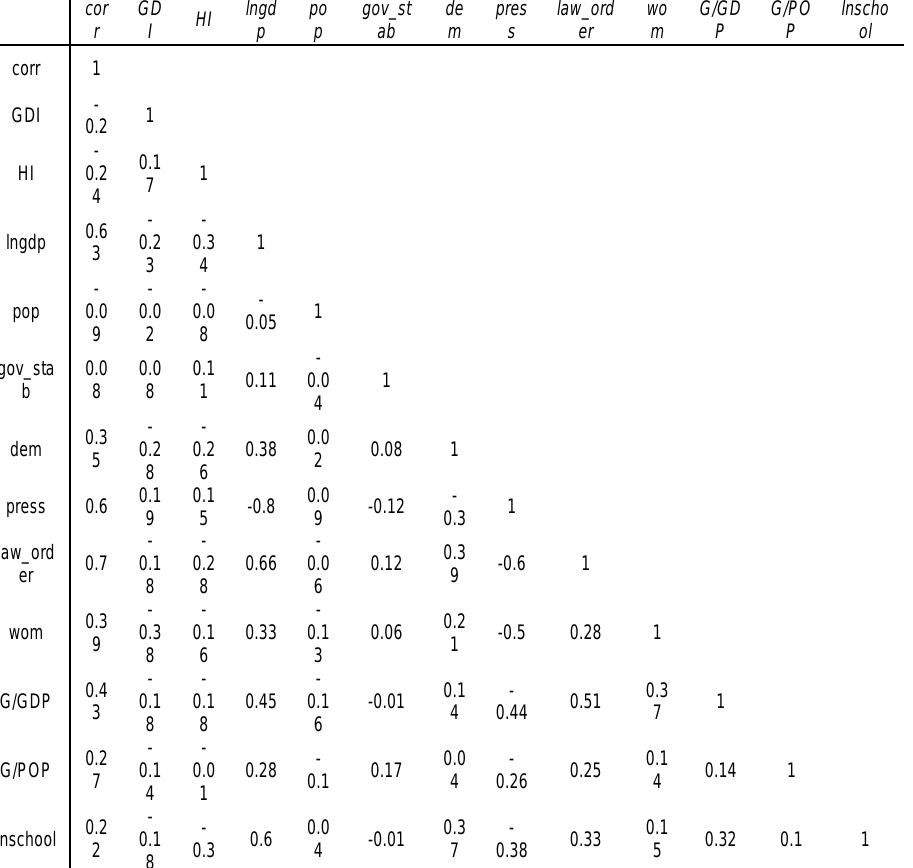
Table A3. Correlations